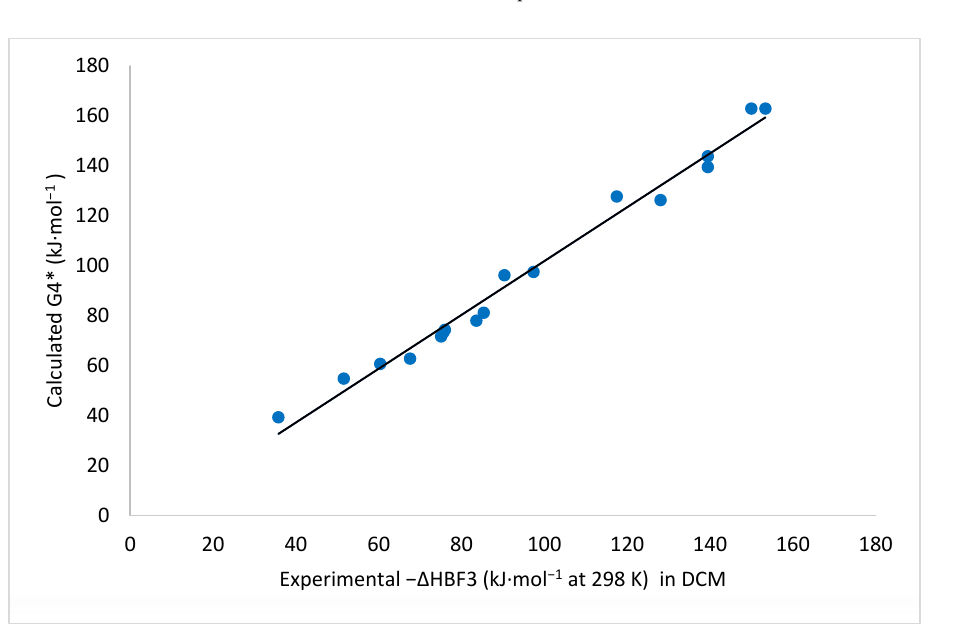
Figure 4. Linear correlation between the experimental enthalpies of adduct formation ( −Δ H BF 3exp . DCM ) and the G4* calculated values obtained using the discrete solvation model.